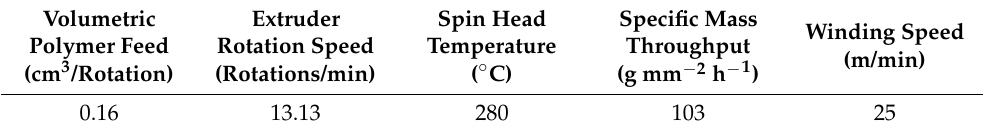
Table 1. Setup and melt spinning parameters for obtaining HF based on PMP.